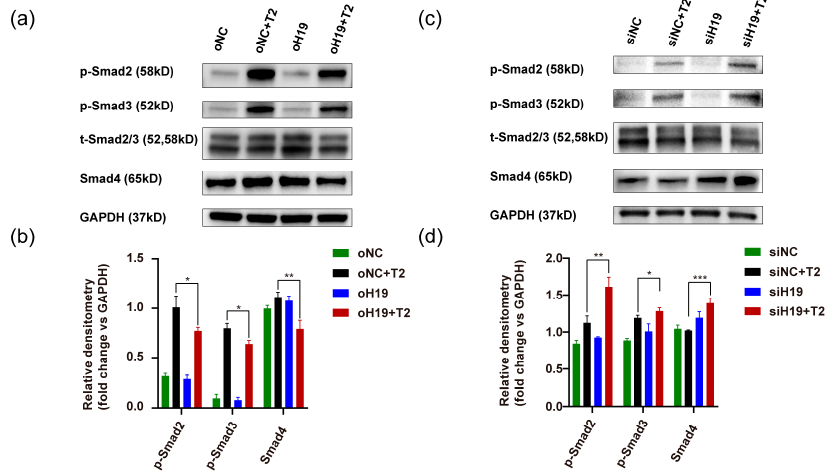
Figure 9. Mechanistic analyses of the role of H19 in regulating TGF- β 2-induced EMT in lens epithelial cells. ( a – d ) SRA01/04 cells were first infected with H19 -overexpressing lentiviruses or negative control for at least 24 h and further treated with TGF- β 2 (5 ng/mL, 24 h). Protein levels of p- Smad2, p-Smad3, total Smad2/3, and Smad4 were examined, using GAPDH as an internal control. Representative western blots and densitometric analyses (mean ± SD) are shown (n = 3 per group). * p < 0.05, ** p < 0.01, *** p <